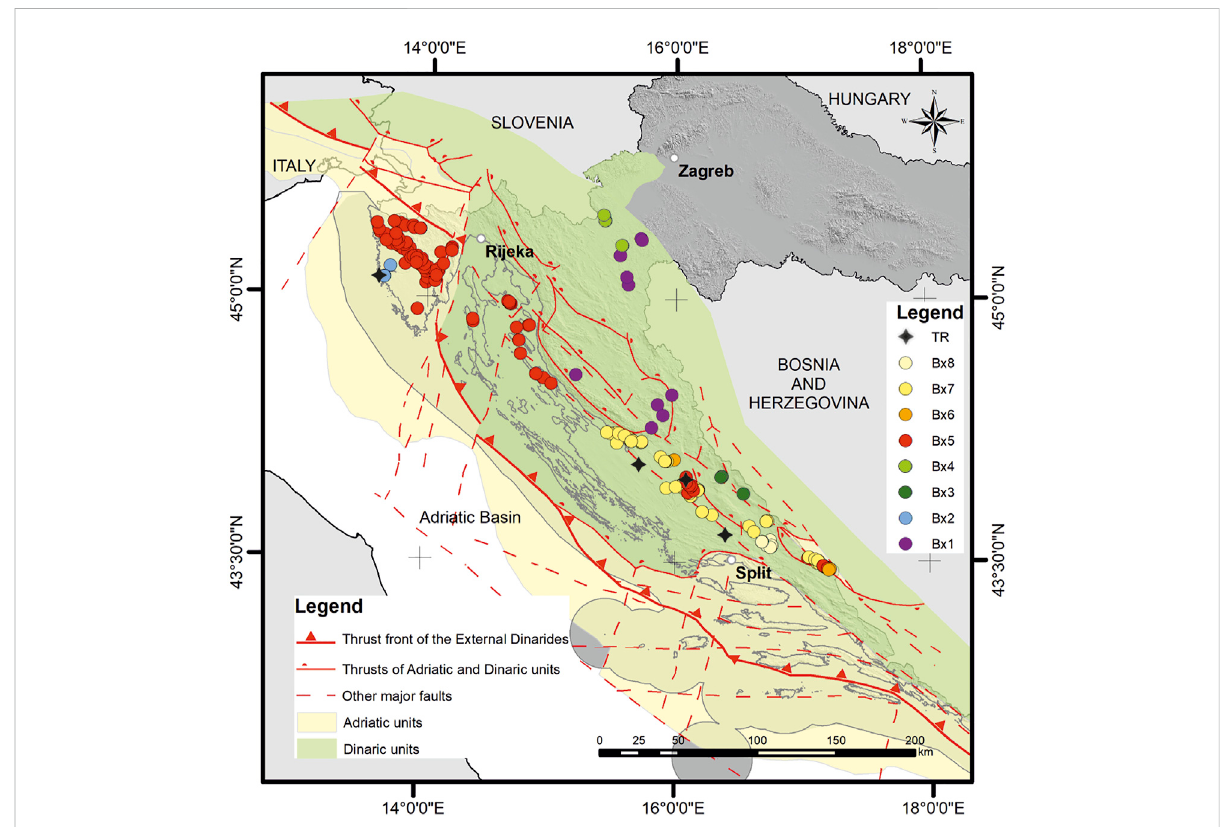
FIGURE 1 Geographical position of the study area showing locations of the sampled bauxites (BX1-BX8) and soils